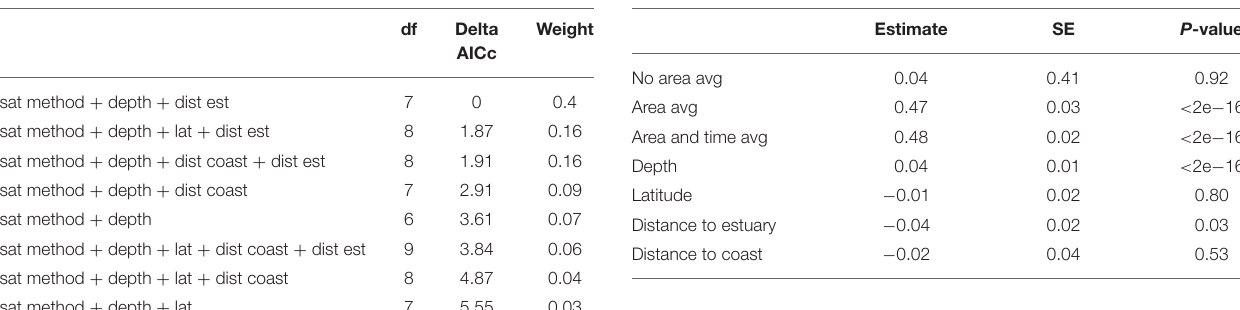
TABLE 4 | Table of the most parsimonious linear mixed models (all models with 1 AIC ≤ 10). df, the degrees of freedom.